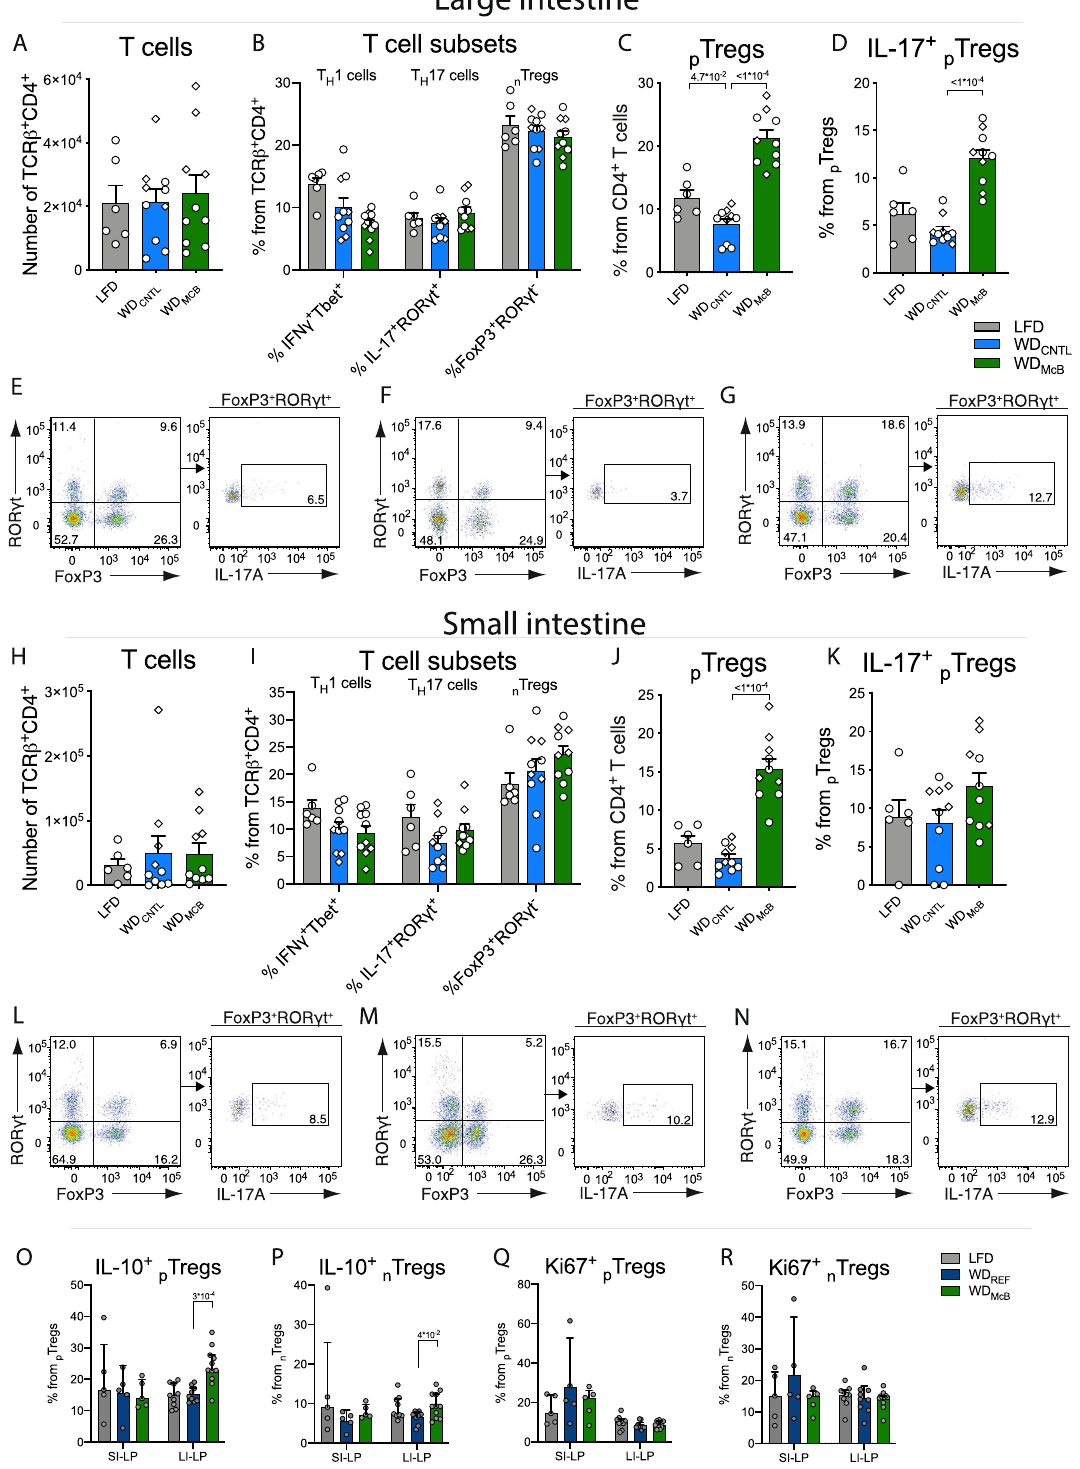
Fig. 2 WD McB feeding stimulates induction of gut-speci fi c regulatory T cells. A – D Number of indicated cells in colon. E – G Representative plots of colonic TCR β + CD4 + FoxP3 + ROR γ t + p T regs (left) and IL-17 + p T regs (right) in LFD ( E ), WD CNTL ( F ), and WD McB ( G ) group. H – K Number of indicated cells in small intestine. L – N TCR β + CD4 + FoxP3 + ROR γ t + p T regs (left) and IL-17 + p T regs (right) in LFD ( L ), WD CNTL ( M ), and WD McB ( N ) group. O – R Percentage of indicated cells in SI- and LI-LP from ‘ weight-matched ’ mice housed at thermoneutrality. A – N Dots indicate individuals data points in Exp1 (squares) and Exp2 (circles) with n = 6 (LFD) or 10 (WD McB and WD CNTL ). O – R SI-LP n = 5 per group and LI-LP n = 9 (LFD and WD REF groups) or 11 (WD McB ). A – D , H – K , O – R Bars indicate group mean ± SEM and dots indicate individual data points. All p -values < 1 × 10 − 1 between WD CNTL and indicated group by one-way ANOVA with multiple comparisons and Dunnett post-hoc are